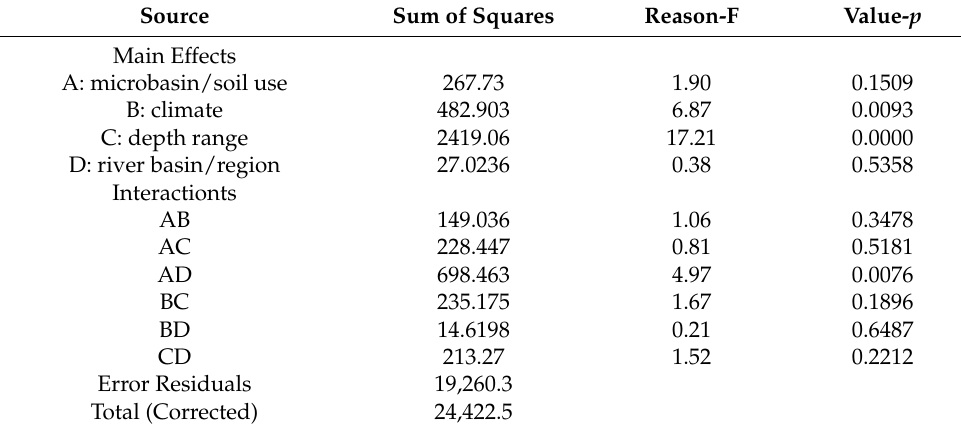
Table 8. Analysis of variance for mean (VSM) sum of squares type